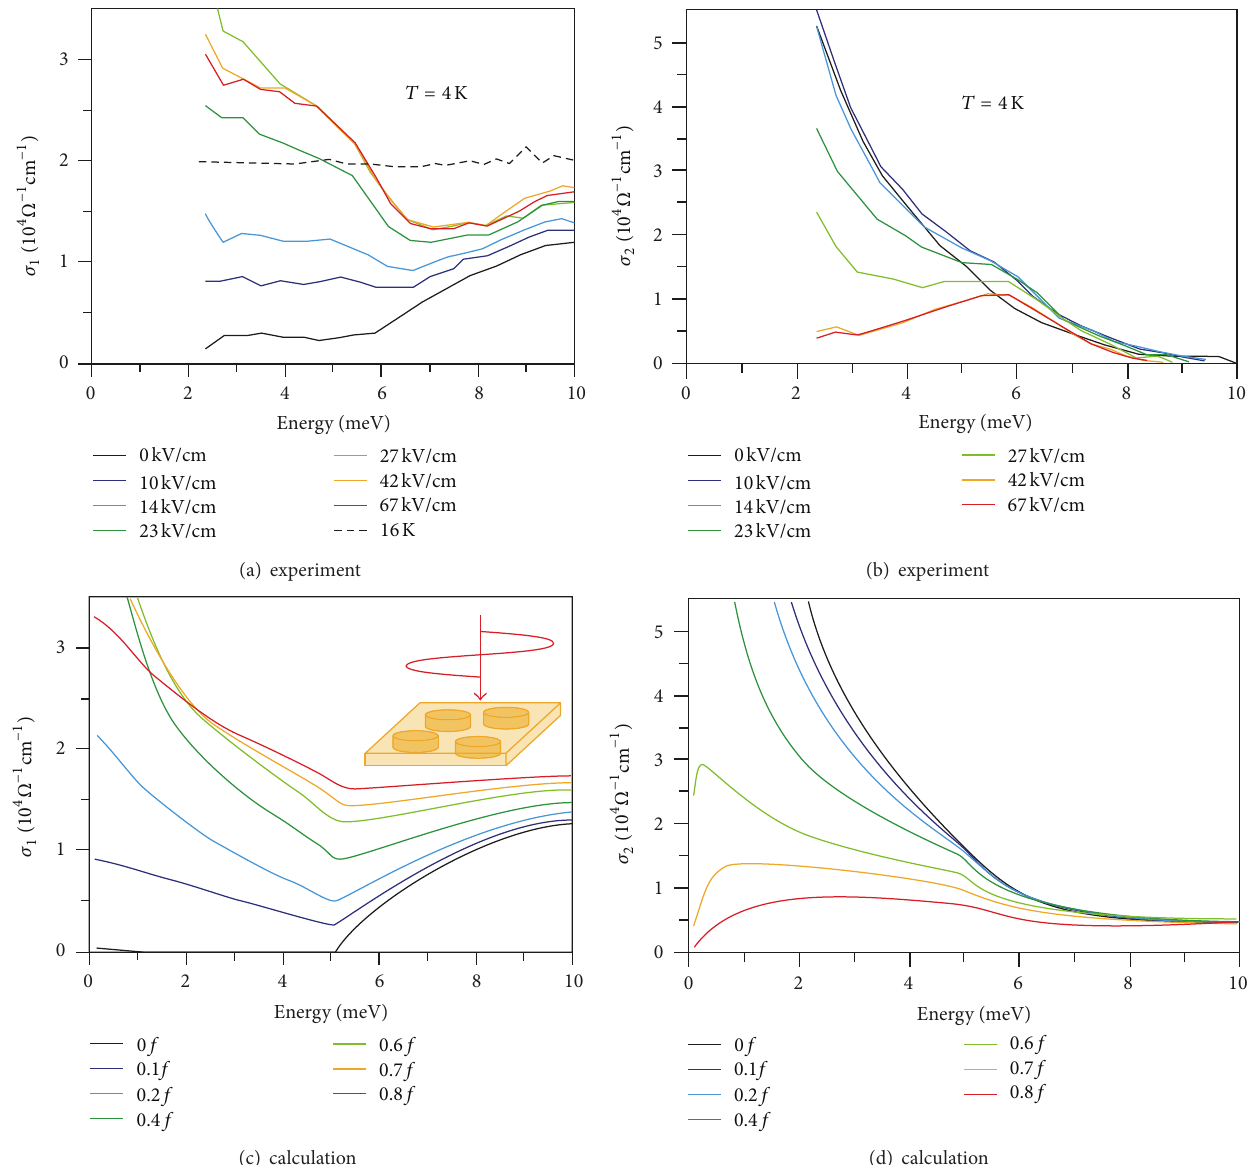
Figure 20: The spectra of the (a) real and (b) imaginary parts of the optical conductivity for various THz excitation intensities at 4K. For reference, 𝜎 1 (𝜔) in the normal metal state at 16K is plotted as a dotted line. Panel (c) and (d) exhibit the calculated real and imaginary parts of the optical conductivity spectra, respectively, using an effective medium approach. The inset is a schematic image of the inhomogeneously suppressed superconductivity (after